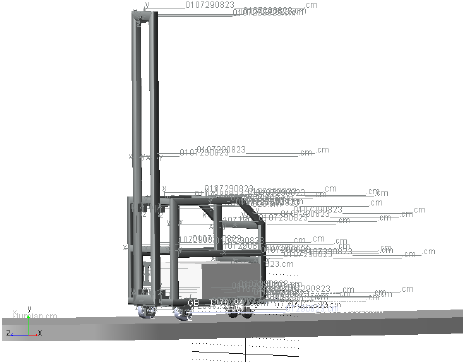
Figure 6. Simplified fork-type AGV model.